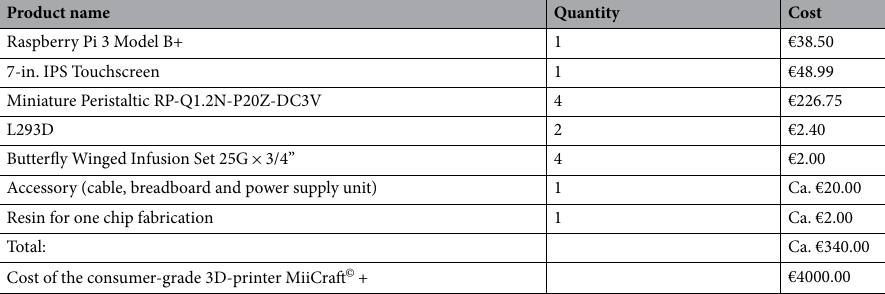
Table 4. Total cost sheet for parts and materials used to prototype the system. Some of the parts are used with an estimated value and indicated by “Ca.” The total cost of the entire system, including the material cost for chip fabrication, is about €340, which is relatively cheap compared to a conventional microfluidic system.